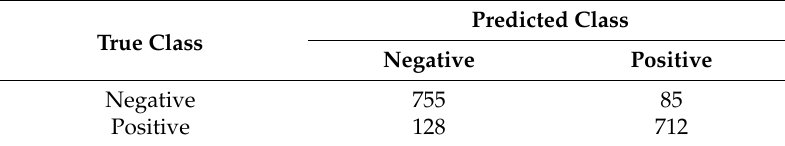
Table 9. Deep FC2 features and DT classifier.